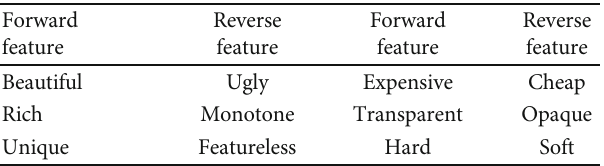
Table 1: Describes the most representative words for jewelry